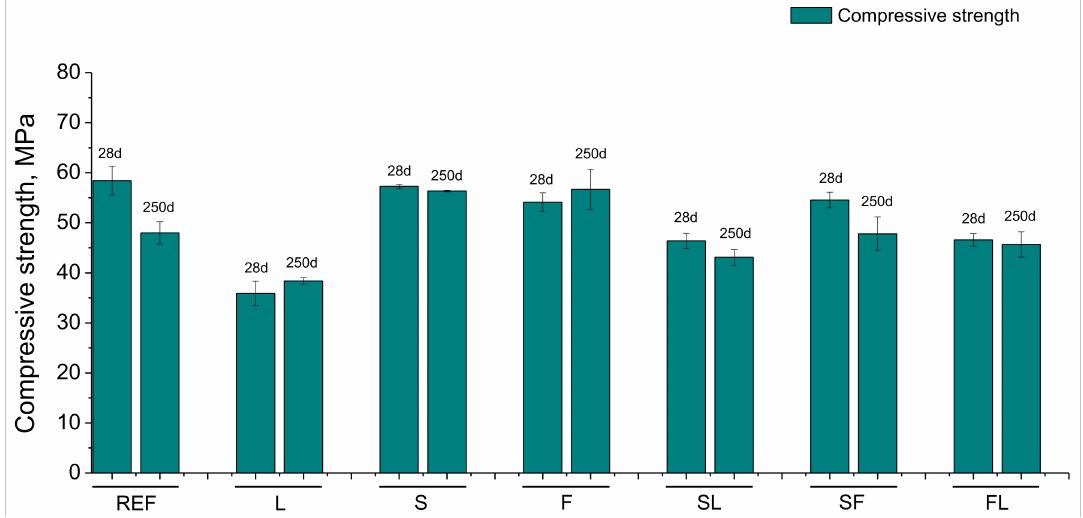
Figure 12. Compressive strength results for the studied binders.